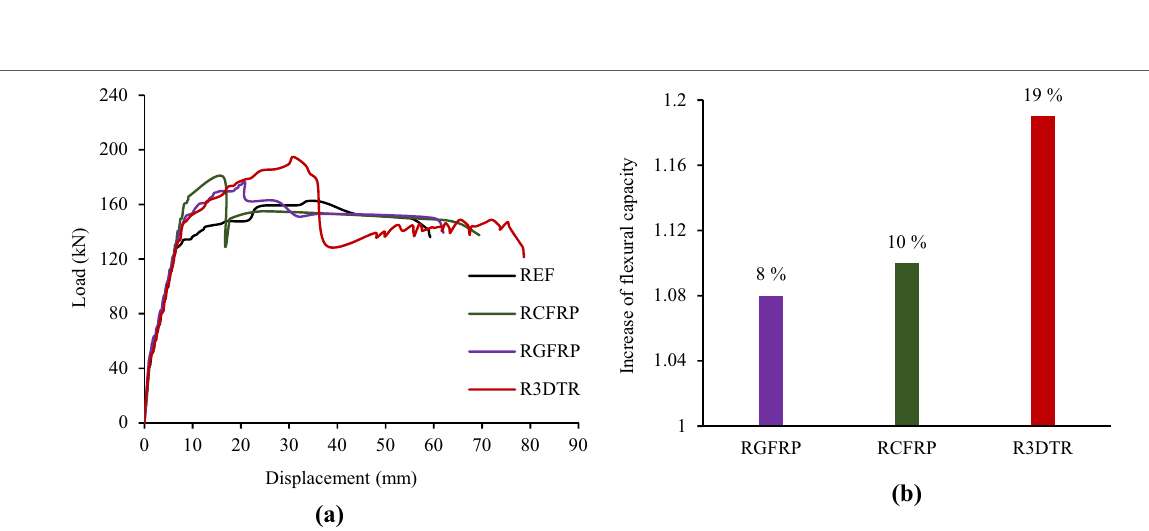
Fig. 9 Comparison of the specimens: a Load–displacement curves of the tested beams, and b increase of the flexural capacity of the strengthened beams in comparison with the REF